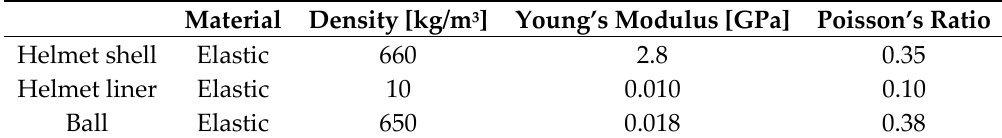
Table 1. Material properties of the helmet parts and the ball.